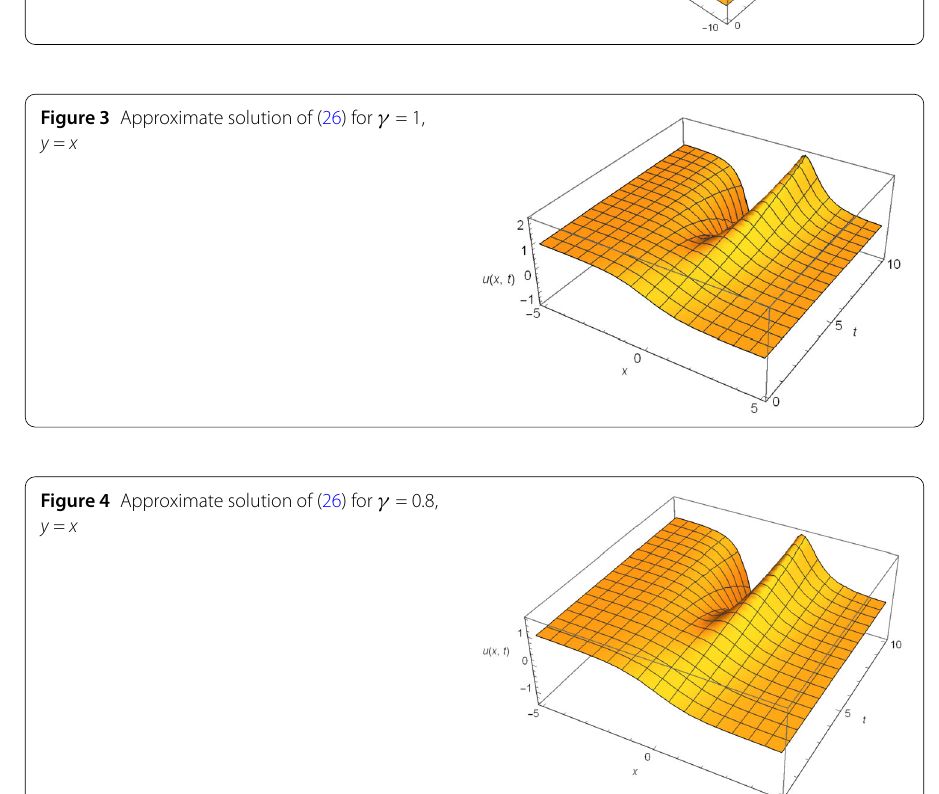
Figure 4 Approximate solution of (26) for γ = 0.8, y =